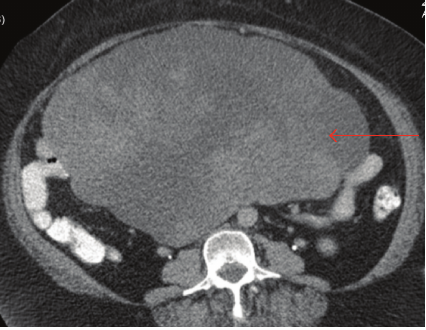
Figure 1: Abdomen CT scan with IV and PO contrast, axial view. Large multilobular mass (red arrow).